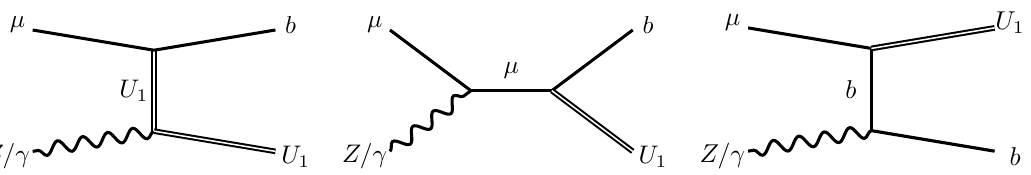
Figure 6 . Diagrams leading to single production of LQs. A vector boson from µ + ( µ − ) collides with µ − ( µ + ) through different channels producing a down-type quark and a